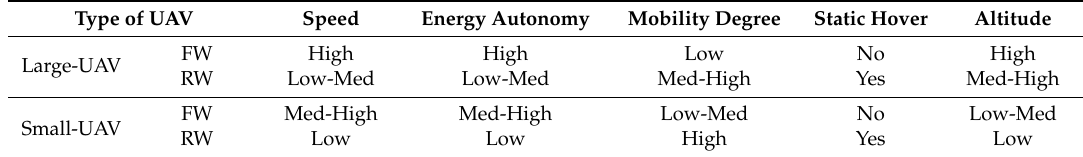
Table 1. Classification of UAVs by